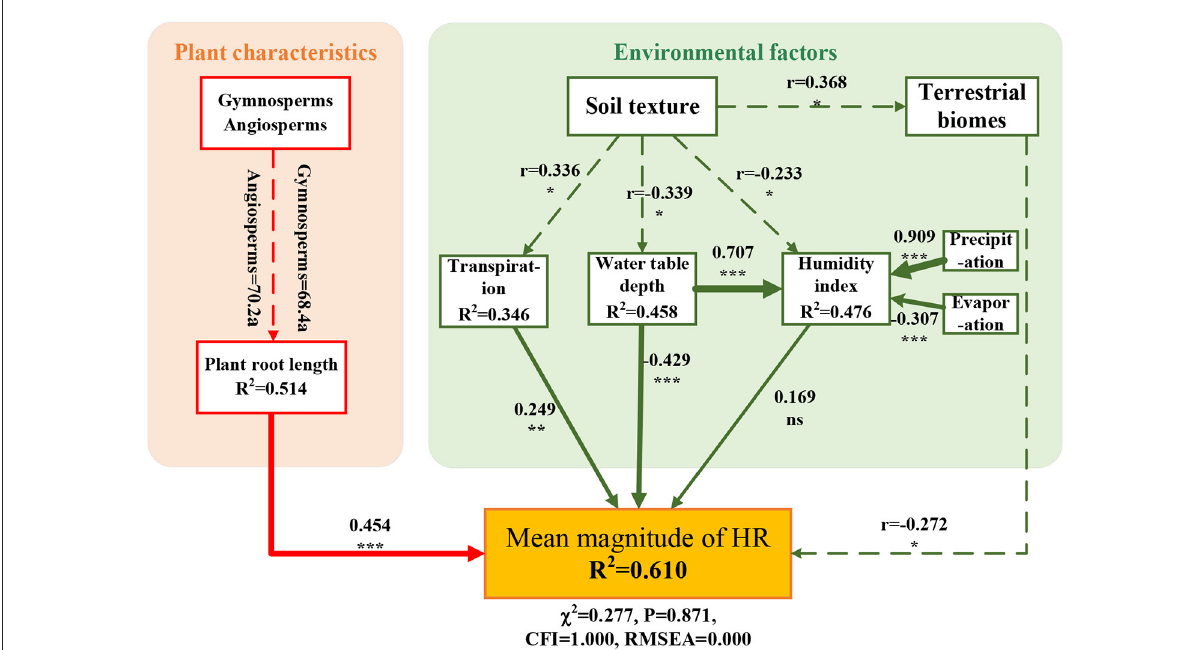
FIGURE5 Direct and indirect effects of environmental factors on the hydraulic redistribution (HR) magnitude based on structural equation modeling (SEM). SEM fitted with range-standardized coefficients, which link plant type, root length, soil texture, terrestrial biomes, transpiration, water table, and humidity index on the magnitude of HR ( χ 2 0.277, P 0.871, CFI 1.000, RMSEA 0.000). The number next to the solid arrow represents the = = = = normalization coefficient, and the line width corresponds to the strength of the standardized coefficient. Notably, gymnosperms, angiosperms, soil texture, and terrestrial biomes are non-numerical variables. The dashed line shows the correlation between variables, and r is the correlation coefficient. Letters a denote groupings based on post-hoc tests. Significance levels are as follows: *** p < 0.001, ** p < 0.01, * p < 0.05, and ns indicates not